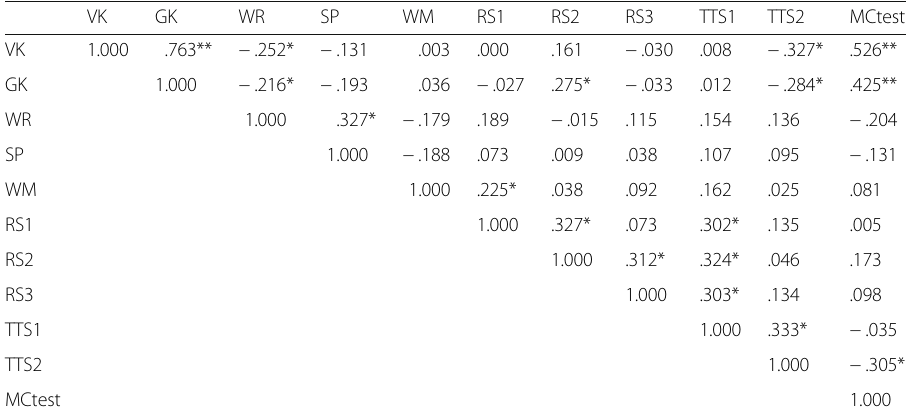
Table 7 Correlations among sub-reading components and MC reading test